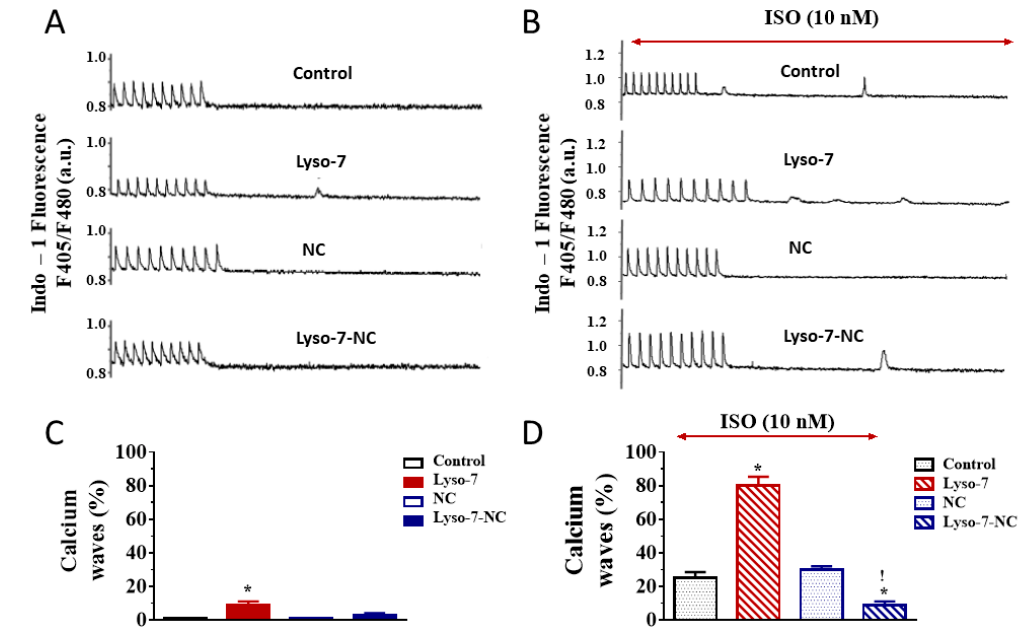
Figure 4. Effect of in vivo administration of Lyso-7 and Lyso-7-NC (1.6 mg/kg, once a day for seven days) on cardiomyocytes’ ectopic diastolic Ca 2+ waves. ( A ) Representative recordings of Ca 2+ waves during resting periods after a train of field stimulation at 1 Hz in cardiomyocytes from the four experimental groups (Control, Lyso-7, NC, and Lyso-7-NC); ( B ) Representative recordings of Ca 2+ waves during resting periods after a train of field stimulation at 1 Hz in cardiomyocytes from the four the same experimental groups treated in vitro with Isoproterenol (ISO, 10 nM); ( C , D ) percentage of cardiomyocytes developing at least one spontaneous Ca 2+ wave in absence and presence of ISO (10 nM) in vitro, respectively, for the four experimental groups (Control, Lyso-7, NC, and Lyso-7-NC). We used a t-test. p < 0.05,* Lyso-7 vs. control; ! Lyso-7-NC vs. Lyso-7. a.u.: arbitrary units. n = 4; n = 12–18.